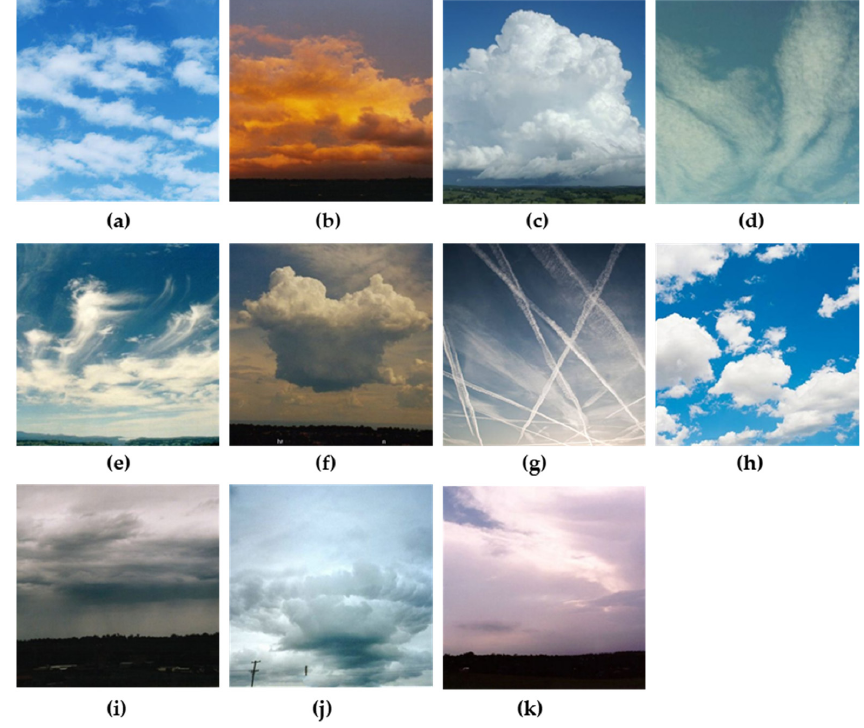
Figure 9. Example images from the CCSN dataset: ( a ) altocumulus (Ac); ( b ) altostratus (As); ( c ) cumulonimbus (Cb); ( d ) cirrocumulus (Cc); ( e ) cirrus (Ci); ( f ) cirrostratus (Cs); ( g ) contrail (Ct); ( h ) cumulus (Cu); ( i ) nimbostratus (Ns); ( j ) stratocumulus (Sc); ( k ) stratus (St). Table 3. Training and testing samples for the CCSN dataset.